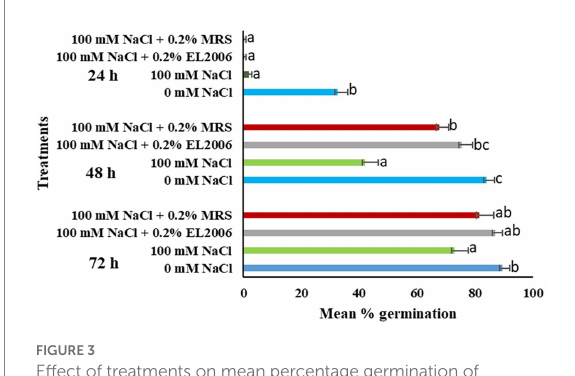
FIGURE 3 Effect of treatments on mean percentage germination of soybean. Data represents mean ± SE ( n = 80); different letters indicate values determined by Tukey’s multiple mean comparison significantly different at p < 0.05. Values with the same letters are not significantly different at p < 0.05.